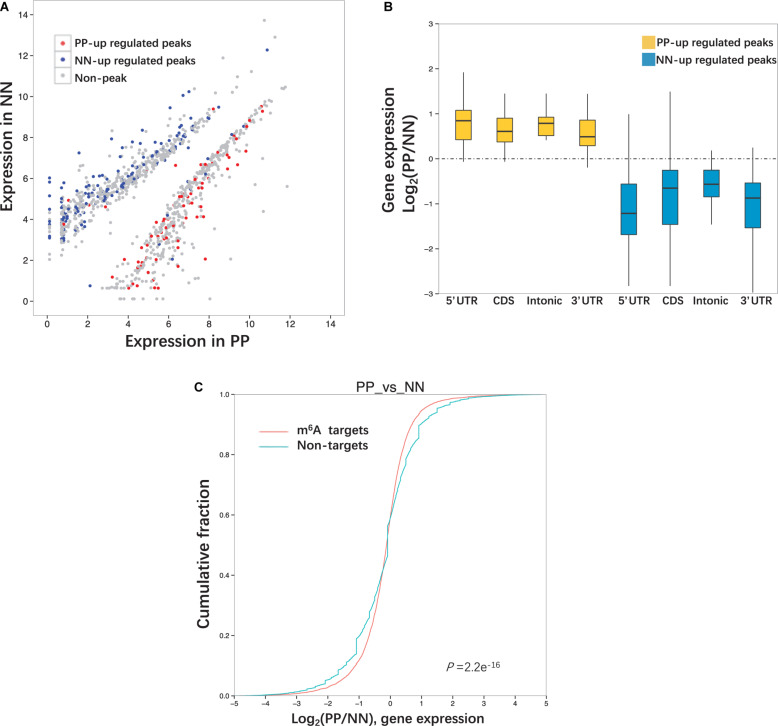
Relationship between m6A peaks and mRNA level. (A) Differentially expressed genes (transcripts) in PP and NN. Genes contained up-regulated m6A peaks are highlighted in red and genes contained down- regulated m6A peaks are highlighted in blue. (B) The ratio of gene expression levels in PP and NN samples containing up-regulated m6A peaks. Genes are divided into four categories (5′UTR, CDS, Intonic, 3′UTR) according to the peak positions. (C) Cumulative distribution of mRNA expression changes between PP and NN for m6A -modified genes (red) and non-target genes (green). P-values are calculated by two-sided Mann–Whitney test.